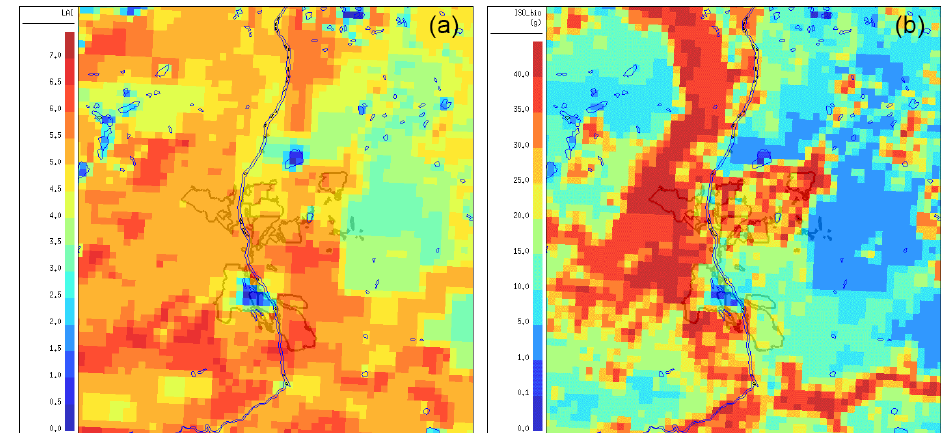
Figure 5. (a) Leaf area index and (b) peak summer isoprene emissions computed on the 2.5km for a portion of the 2.5km OS grid centered on the AOSR study area from the original BELD3 database. The gray lines indicate the cleared areas within the boundaries of the six AOSR mining and processing facilities (see Fig. 1).